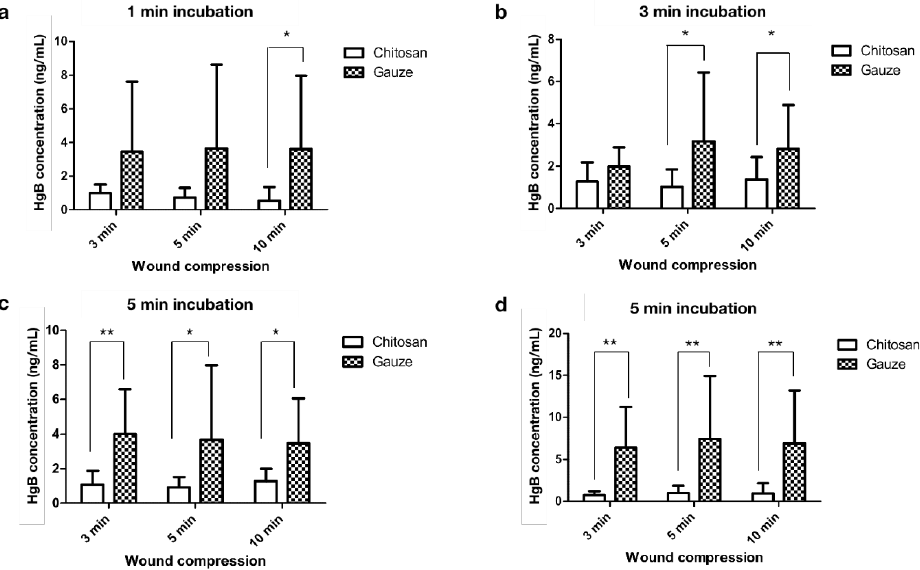
Figure 4. Hemoglobin concentration of chitosan and regular gauze dressings in contact with ab- dominal surgical wounds (3, 5, and 10 min wound compression) in normal saline solution incubated for ( a ) 1, ( b ) 3, ( c ) 5, and ( d ) additional 5 min (* p < 0.05, ** p < 0.01). ( a ) 1, ( b ) 3, ( c ) 5, and ( d ) additional 5 min (* p < 0.05, ** p <